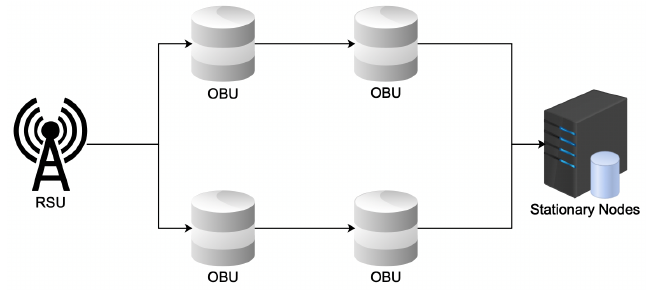
Figure 2. Network